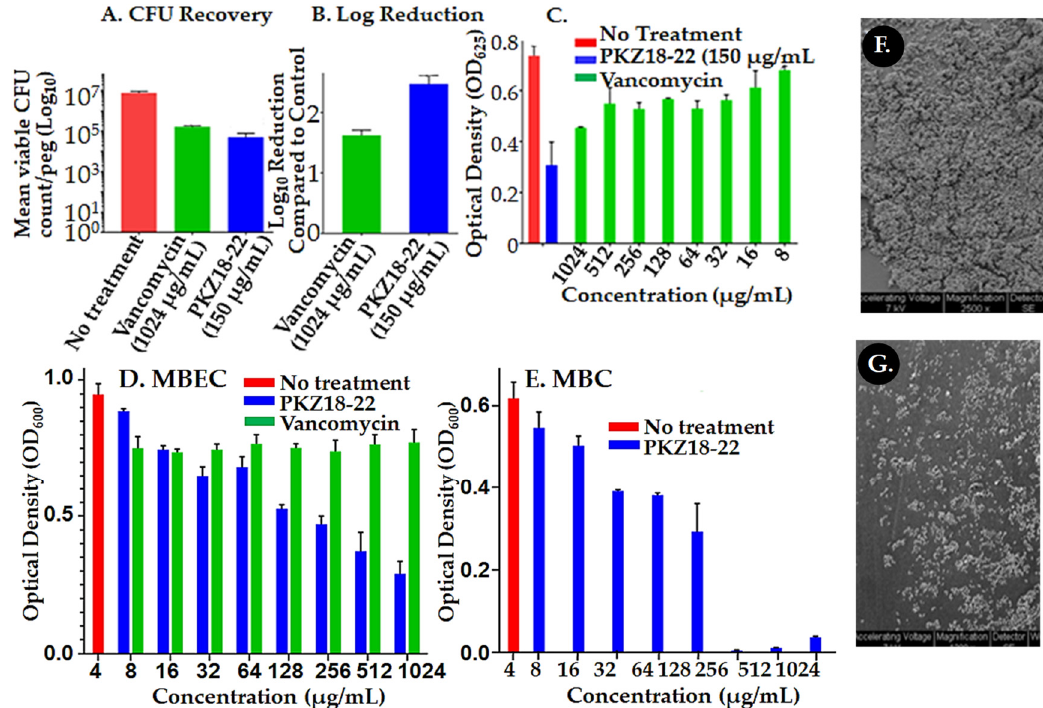
Figure 2. Assessment of PKZ18-22 effect on Staphylococcus biofilms. ( A ) S. aureus biofilm colony forming units (CFU/log 10 ) after 24 h of a single dose antibiotic and the PKZ18 analog PKZ18-22. ( B ) Log reduction after a single dose 24 h challenge. PKZ18-22 treatment exhibited 2.5 log reduction, which corresponds to >99% bacterial cell reduction; significantly greater reduction compared to vancomycin. ( C) Growth of S. aureus after 24 h exposure to PKZ18-22 vs. dosages of vancomycin in the minimum biofilm eradication (MBEC) biofilm model. Optical density measured as a surrogate for turbidity/bacterial growth demonstrated significant growth reduction with PKZ18-22 treatment compared to all vancomycin concentrations and negative controls. ( D ) The MBEC efficacy of a range of concentrations of PKZ18-22 compared with vancomycin using the same parameters as C. (inoculum, media concentration, etc.) but using new lot of PKZ18-22 and vancomycin stocks. No growth with vancomycin. ( E ) The minimum bactericidal concentration (MBC) efficacy of a range of concentrations of PKZ18-22. Scanning electron micrographs of peg surfaces: ( F ) no treatment and ( G ) treatment with PKZ18-22.